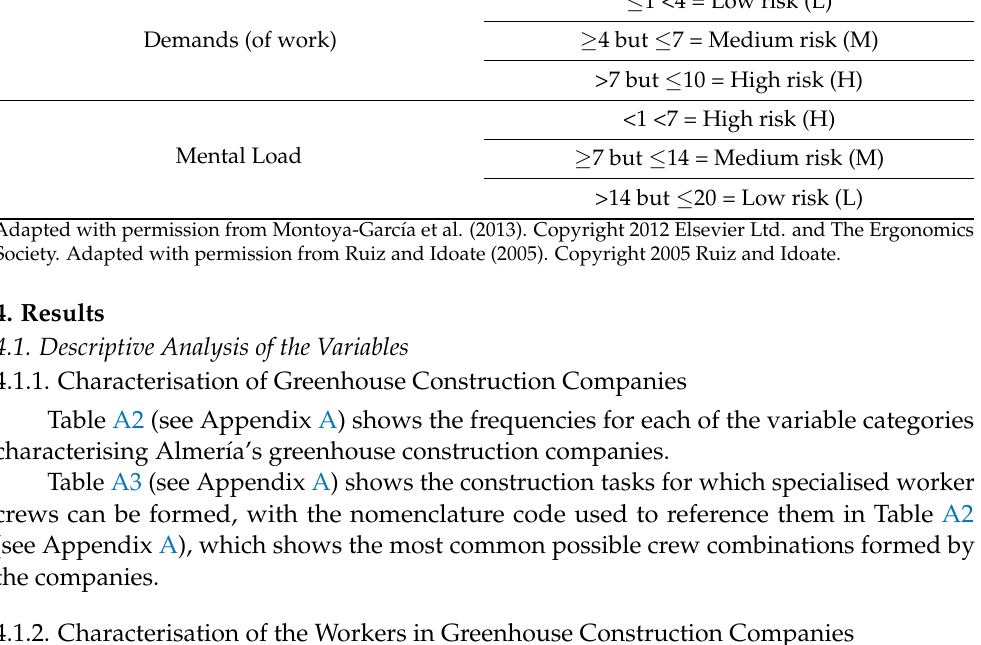
Table 1. Scales for evaluating the scores of each MPF-method variable [65,66]. MPF-Method Variables Ratios Rhythm, Mobbing, Relationships, Health, Recognition, Autonomy, Emotional involvement, Support, Compensation, Control Demands (of work)